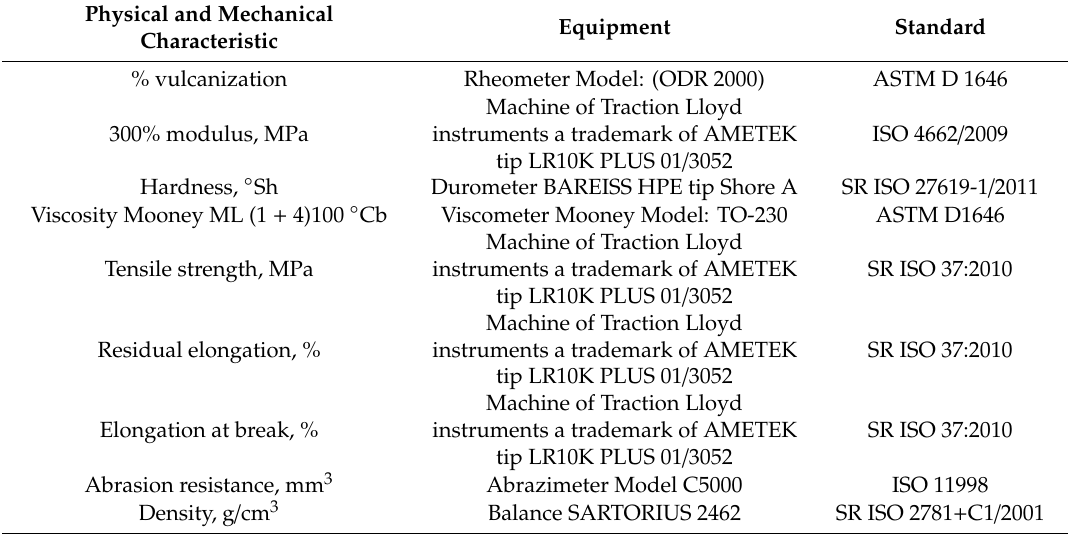
Table 3. Specific equipments and standards used to determine the physical and mechanical